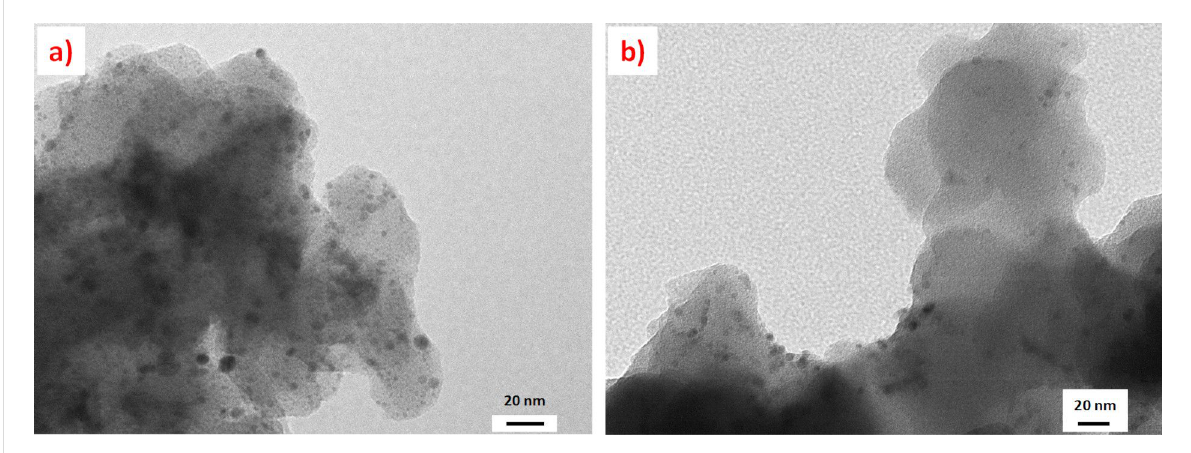
nism can be established favored by the presence of the sup- ported ionic liquid-like phases. SILLPs with a relatively low loading of methylimidazolium units provided the most efficient systems to be used in conjunction with the immobilized